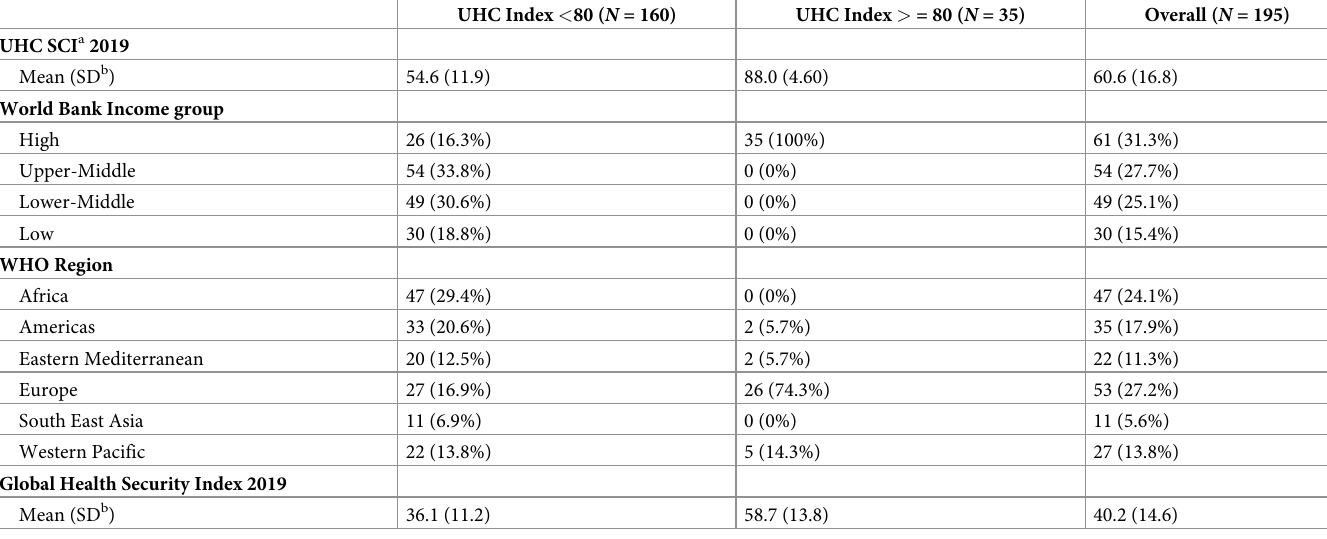
Table 2. Summary characteristics of the countries included in the analysis ( N = 195) based on the cutoff value of 80 for the UHC SCI